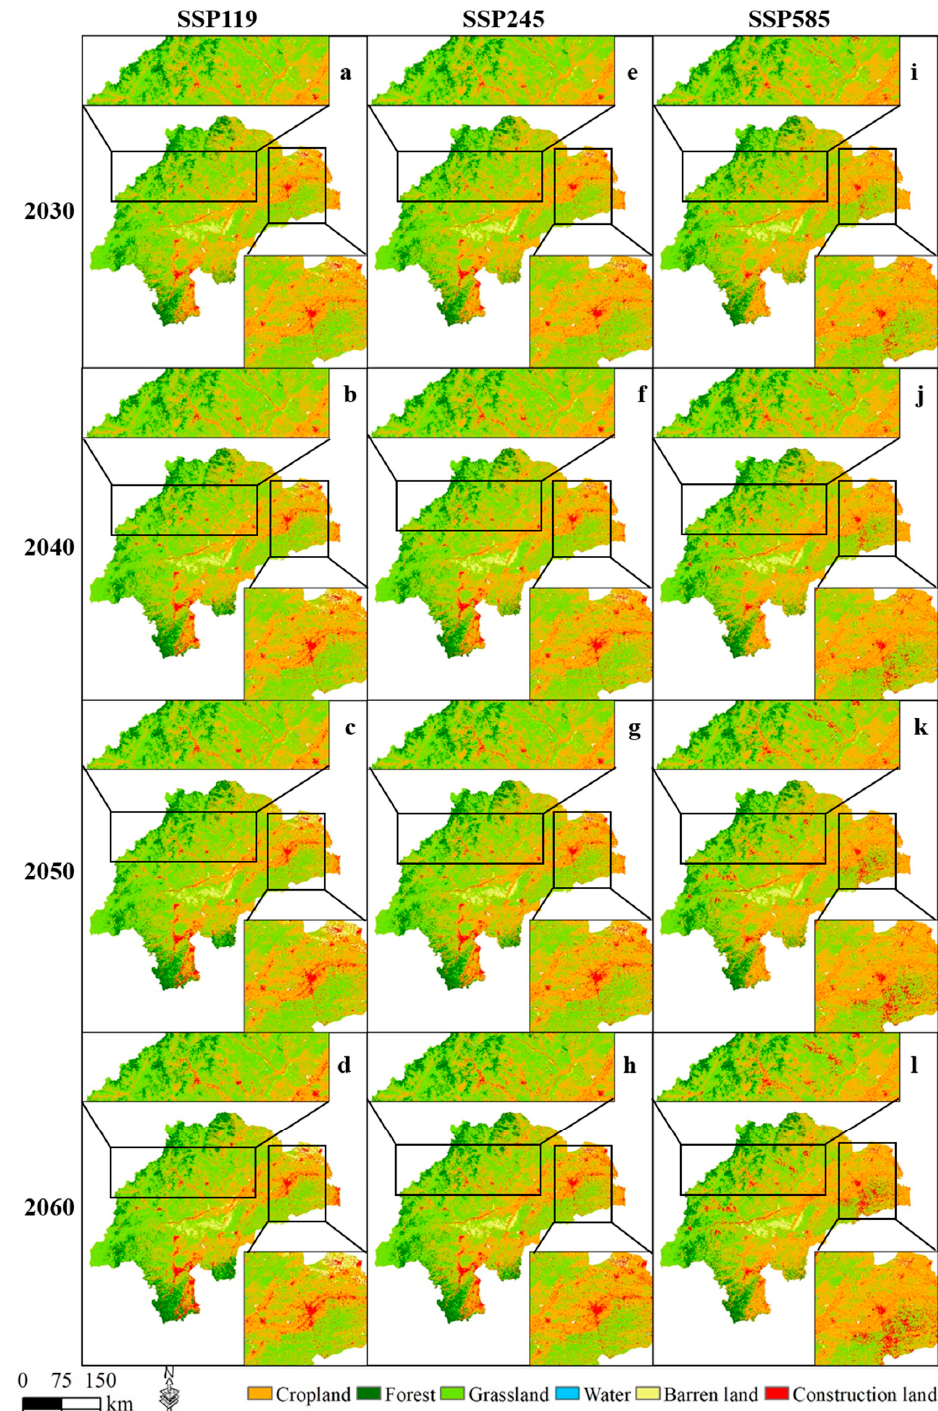
Figure 5. LULC patterns under SSP119 ( a – d ), SSP245 ( e – h ), and SSP585 ( i – l ) for four future periods: 2030s, 2040s, 2050s, and 2060s.